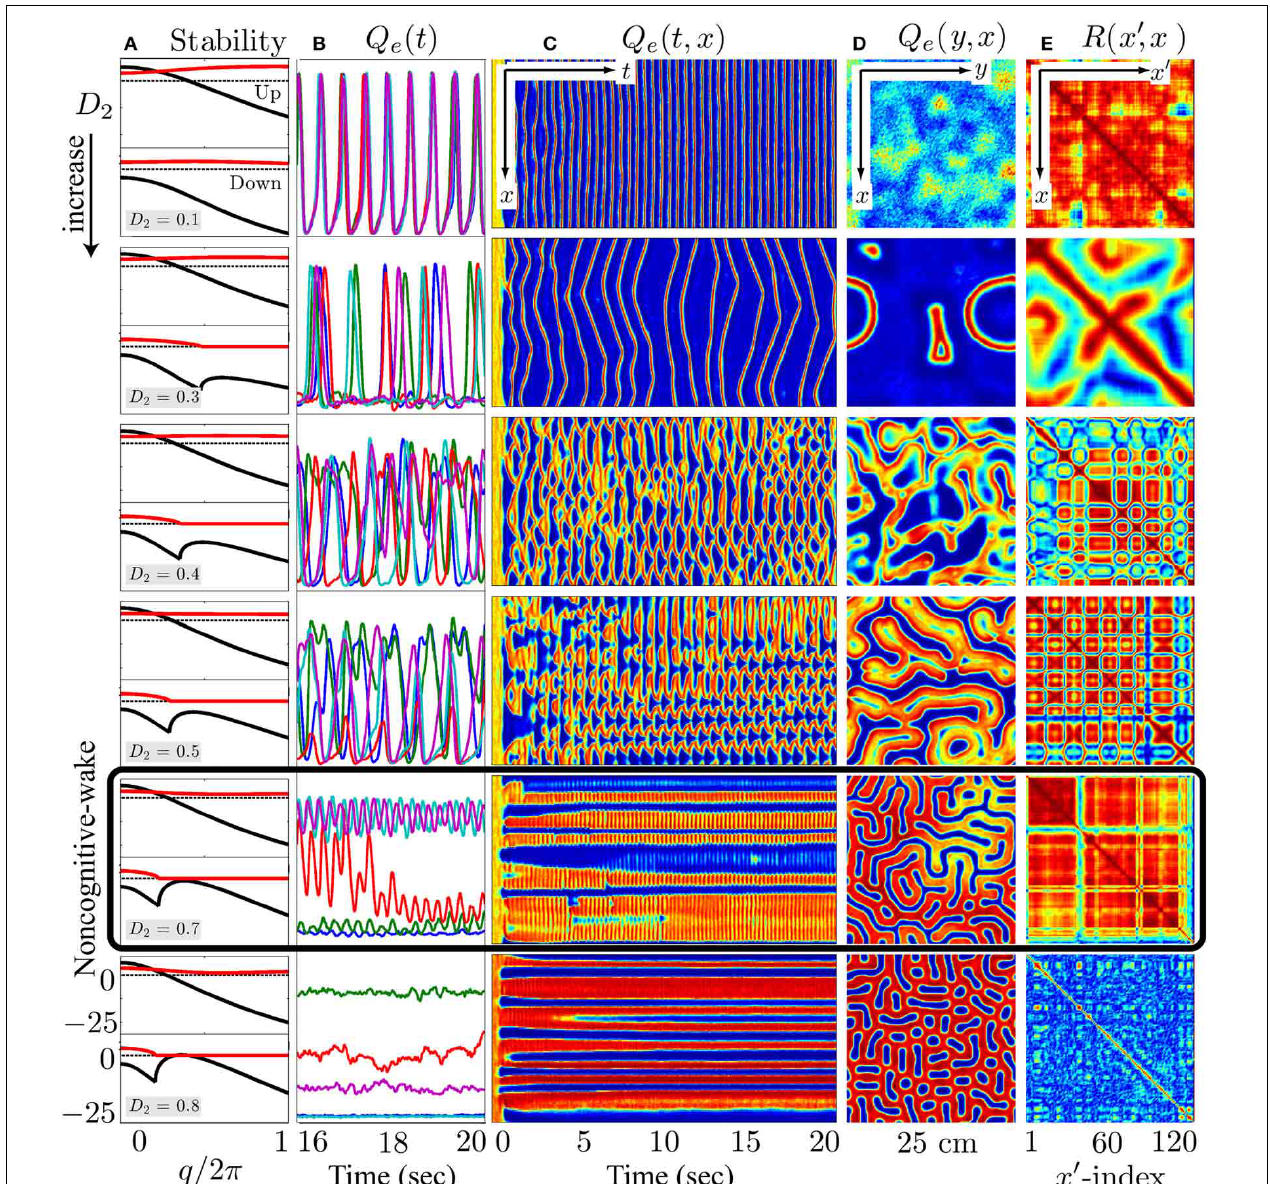
FIGURE 9 | At the λ i = 1 . 0 wake state, cortical stability analysis and spatiotemporal dynamics for varying gap-junction strength D 2 from 0.1 (top row) to 0.8cm 2 (bottom). Model cortex is initialized from the top high-firing branch of steady-state manifold marked as “Awake” in Figure 8 . (A) Cortical stability analysis showing dominant eigenvalue dispersion curve of the real (black) and imaginary (red) parts as a function of scaled wavenumber for top- and bottom-branch equilibria at fixed anesthetic effect λ i = 1 . 0 in Figure 8 . Thus, each panel has two parts in it—the upper part corresponds to the top-branch, the lower part to the bottom-branch. The dotted line marks zero. (B) Last 4-s time-series of